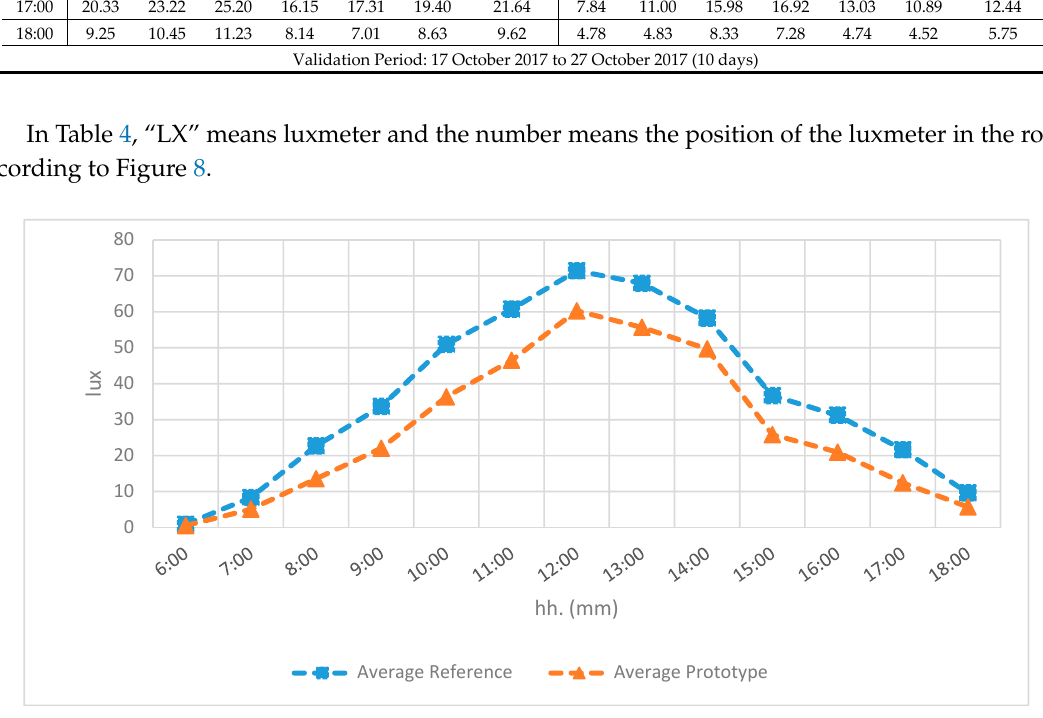
Figure 8. Graph of the average hour of the validation days (Reference vs. Prototype).